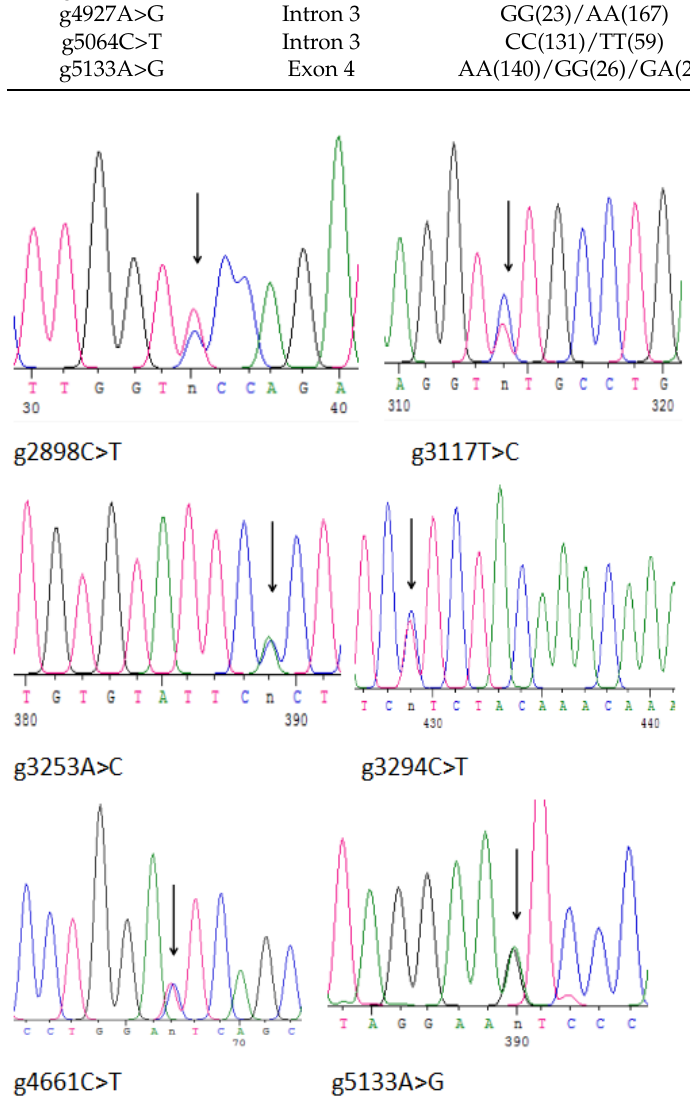
Figure 5. Peak chart of the SNPs of igf2 in L. maculatus. The arrows represent the mutation posi- tion.